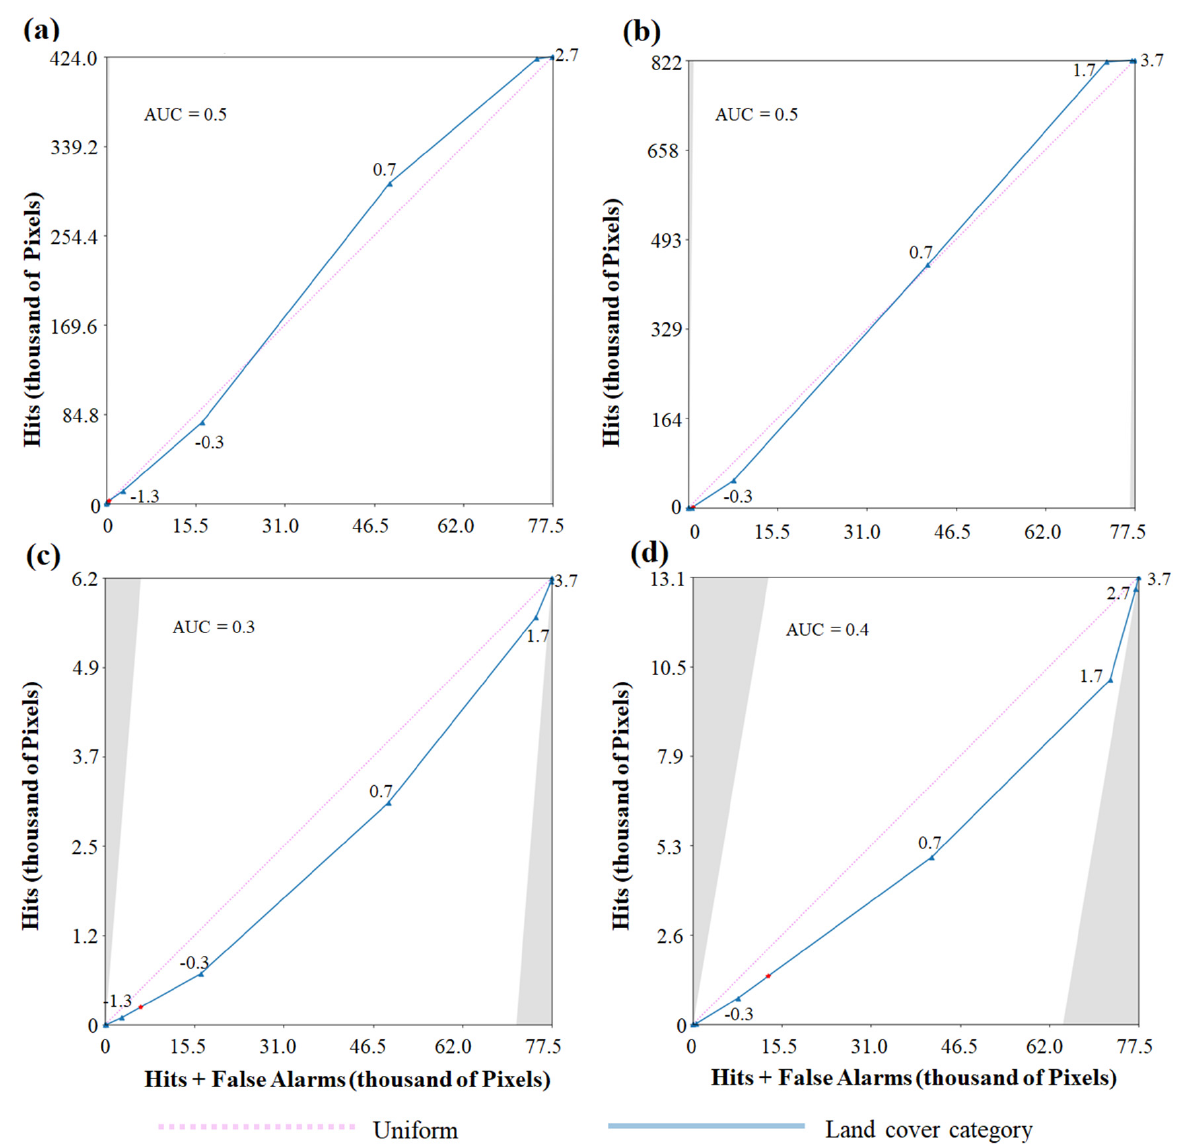
Figure 6. TOC curves for the losses of ( a , b ) infrastructure during the first and second time intervals, and ( c , d ) vegetation during the first and second time intervals. The red mark on the curves shows the threshold at which misses = false alarms.